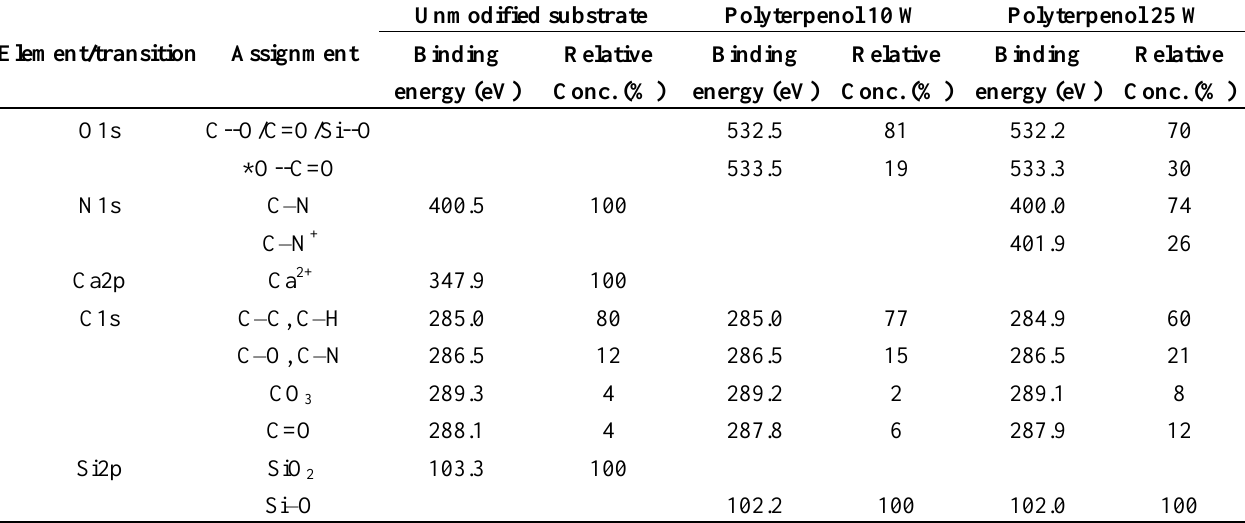
Table 2. Relative contributions of different chemical states on the surfaces of polyterpenol thin films assigned to the X-ray photoelectron spectroscopy (XPS)